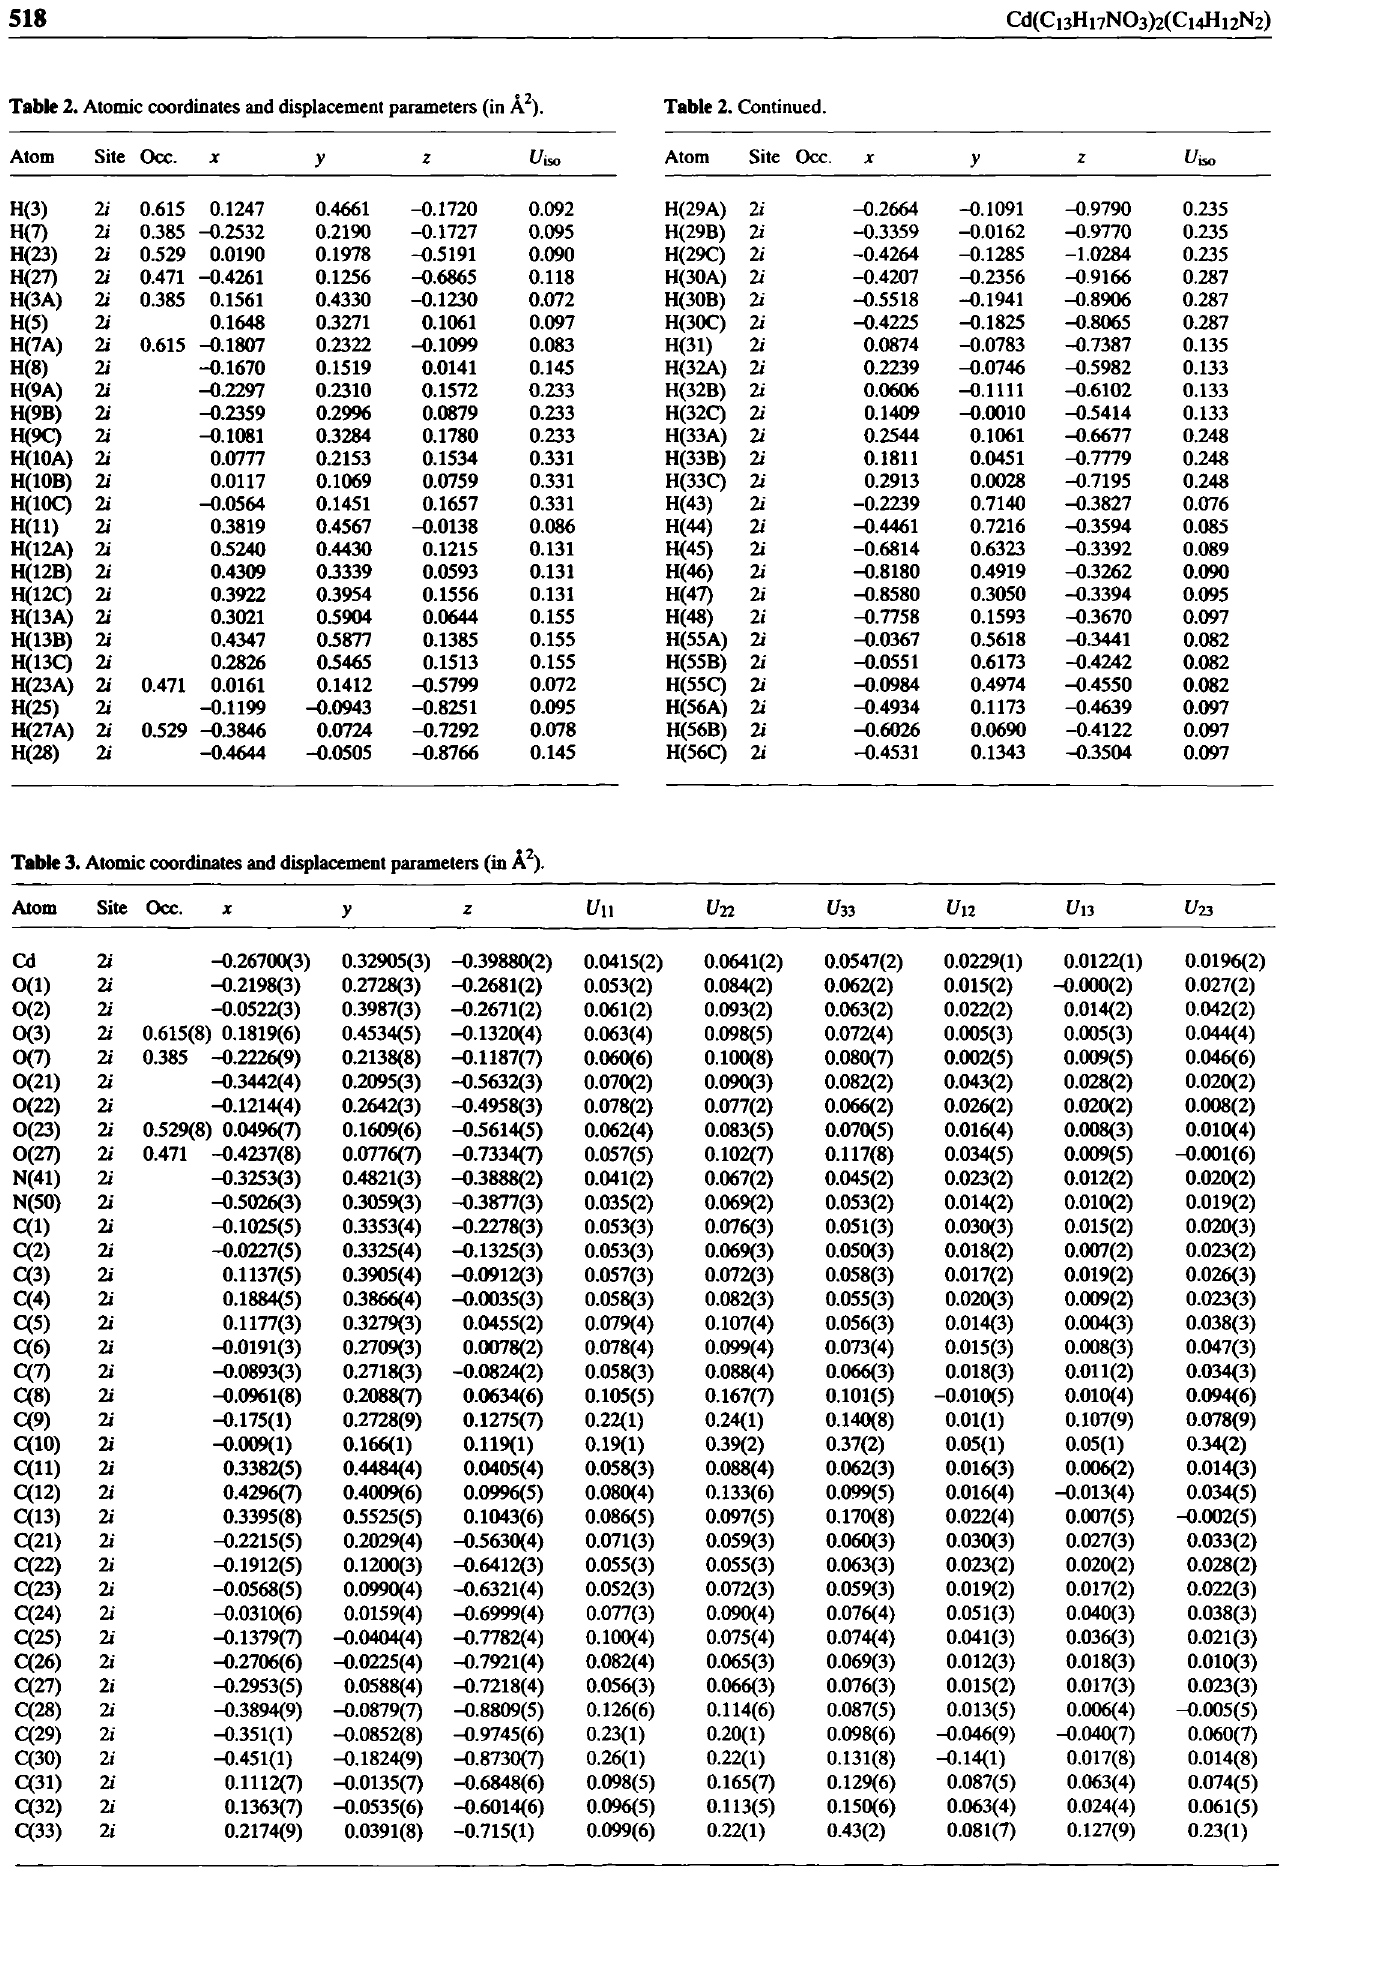
Table 3. Atomic coordinates and displacement parameters (in Ä 2